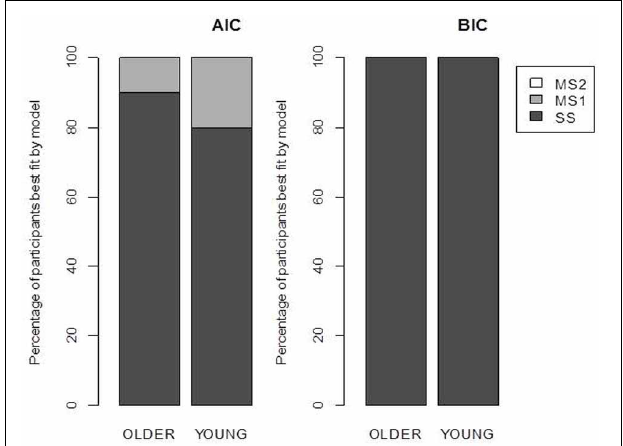
FIGURE 3 | Model selection results. Each bar represents the percentage of participants best fit by each model according to the Akaike Information Criterion (AIC) and the Bayesian Information Criterion (BIC). SS, single-system model; MS1, multiple-systems-1 model; MS2, multiple-systems-2